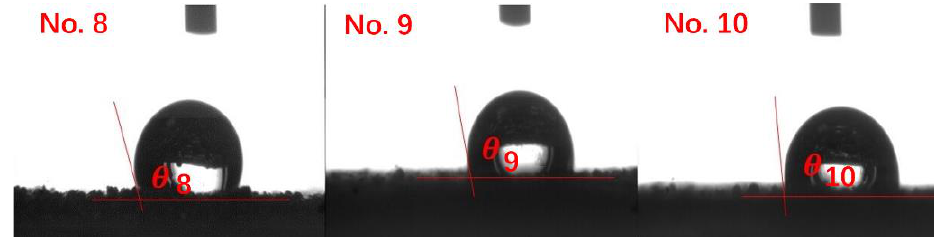
Figure 14. Contact angle measurement of LCC specimens No. 8 – 10.